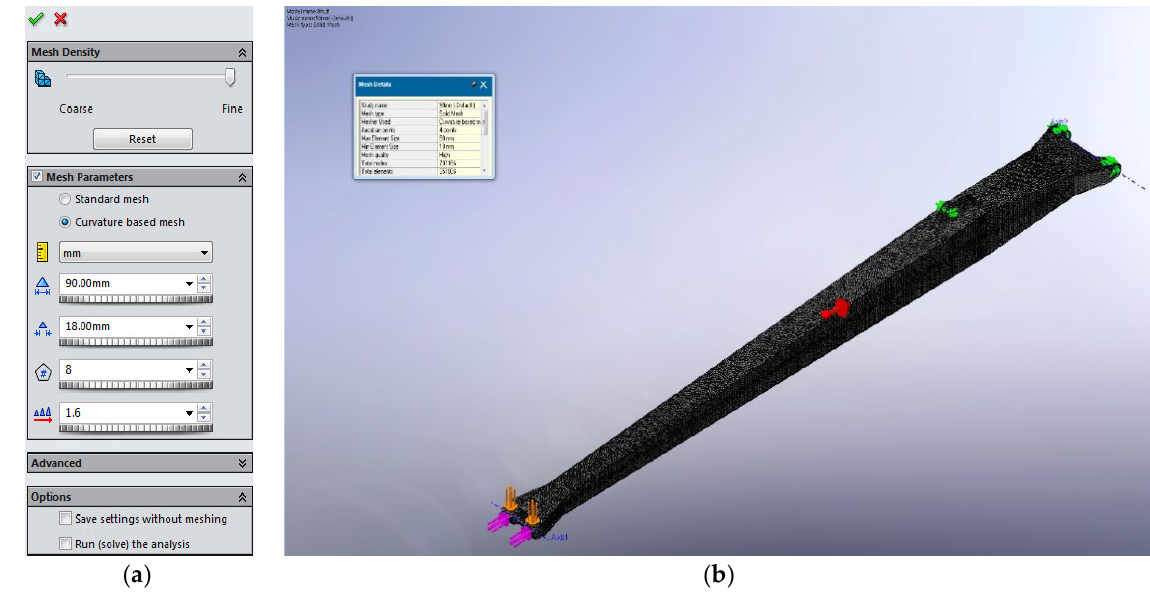
Figure 8. Main boom (arm) meshing ( a ) mesh parameters ( b ) mesh details.